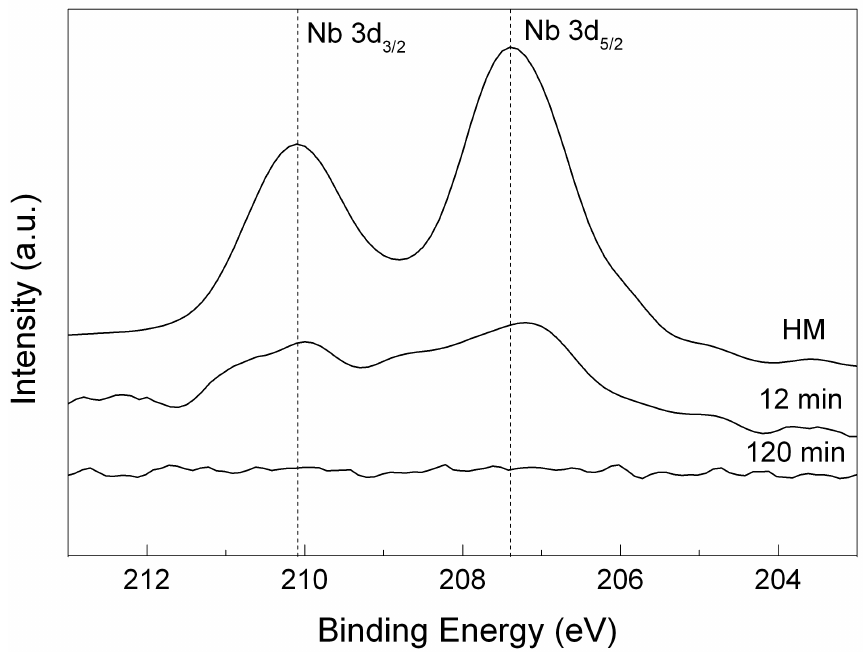
Figure 4. XPS spectra of Nb3d for the catalyzed